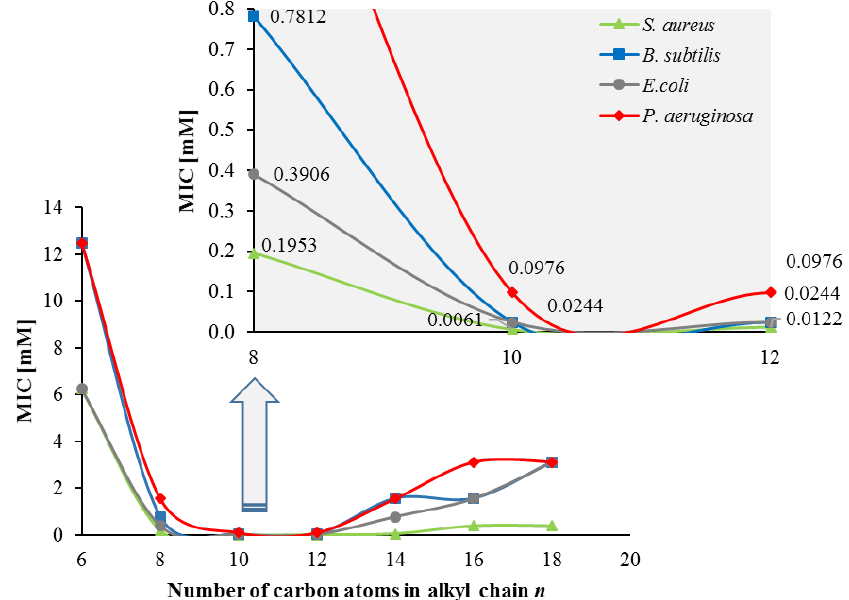
Figure 10. Antibacterial activity of compounds 2 – 9 .